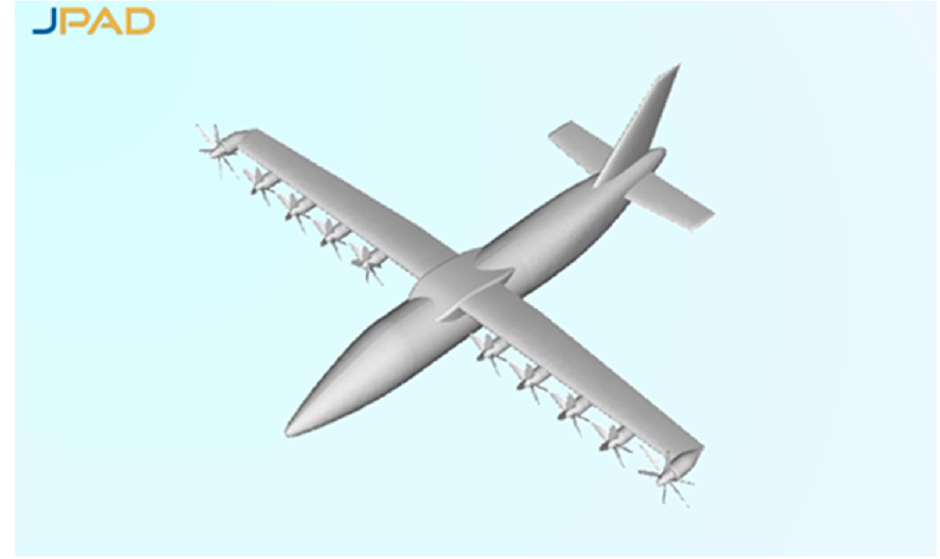
Figure 1. A sketch of aircraft geometry, commuter aircraft 19 pax, obtained by means of JPAD.